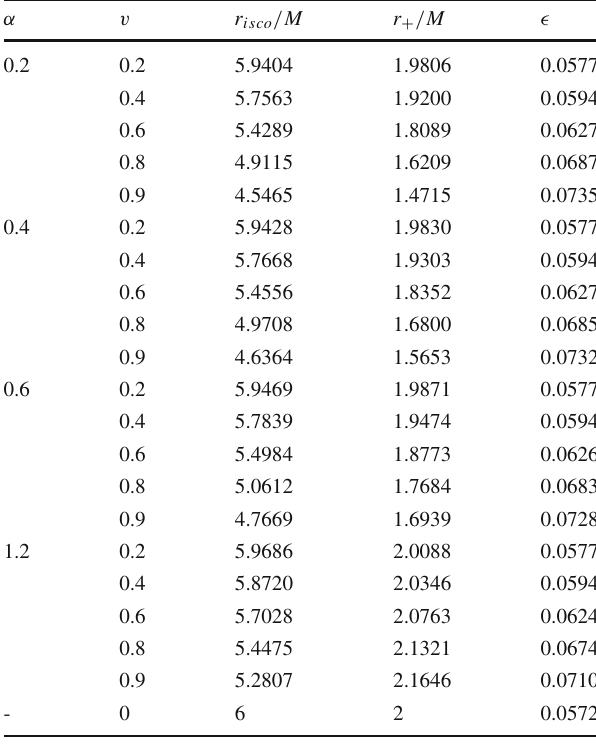
Table 1 The r isco of the accretion disk and efficiency for a static, charged dilaton black hole